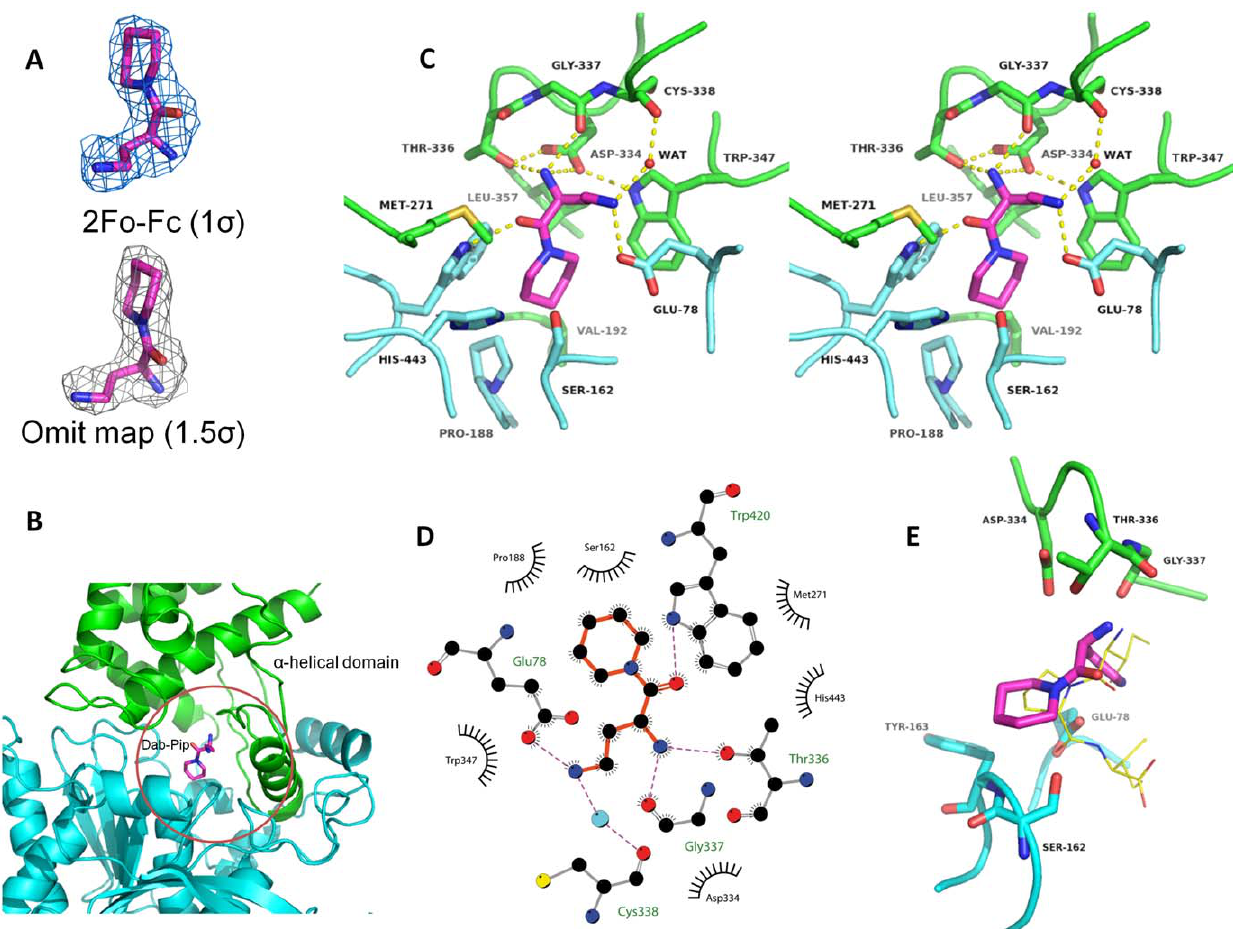
Figure 6. Inhibitor Dap-Pip in the DPP7 active site. ( A ) Omit and 2Fo-Fc electron density maps for the bound inhibitor are shown at 1 and 1.5 s , respectively. ( B ) General overview of the inhibitor in the binding pocket. The a / b –hydrolase domain is shown in aquamarine and the SKS–domain in green. The inhibitor is shown in magenta. ( C ) Stereo view of the residues involved in inhibitor binding. The coloring scheme is the same as above. Dashed yellow lines denote hydrogen bonding interactions ( D ) Representation of the interaction of the inhibitor with surrounding residues prepared using LigPlot + [60]. ( E ) Superimposition of the DPP7 Dab-Pip complex with the structure of DPP4 complexed with Diprotin A [42]. The coloring scheme for DPP7 is the same as above. The Diprotin A is shown using thinner, yellow sticks. The figure was prepared using the program PyMOL (http://www.pymol.org/).